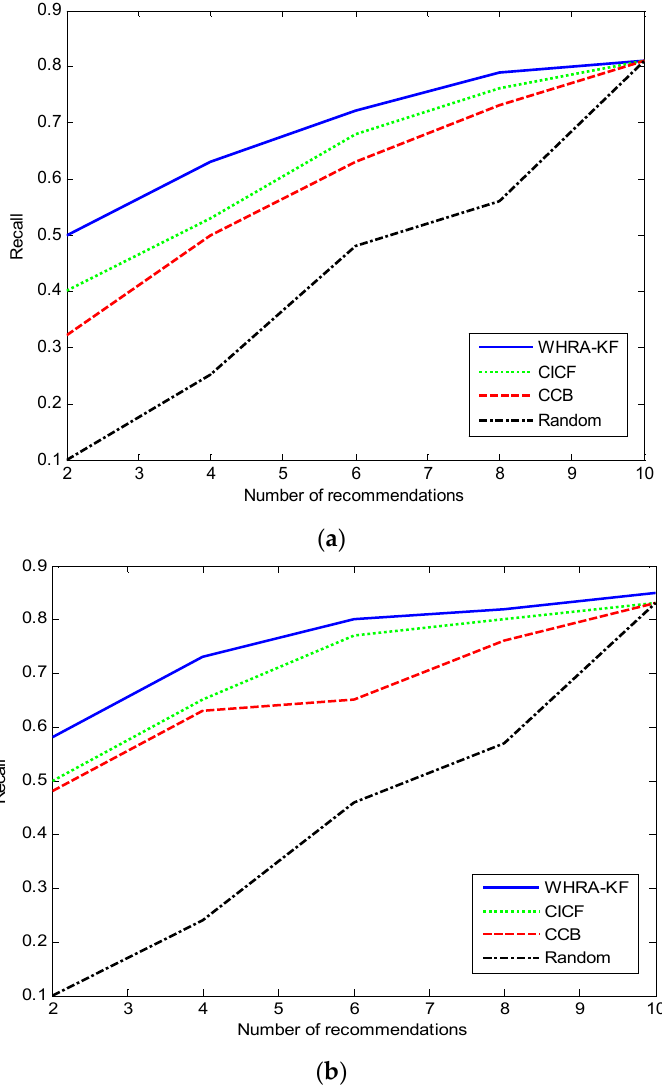
Figure 8. Recall VS number of recommendation for smart home, ( a ) 50 n ; ( b ) 100 n .